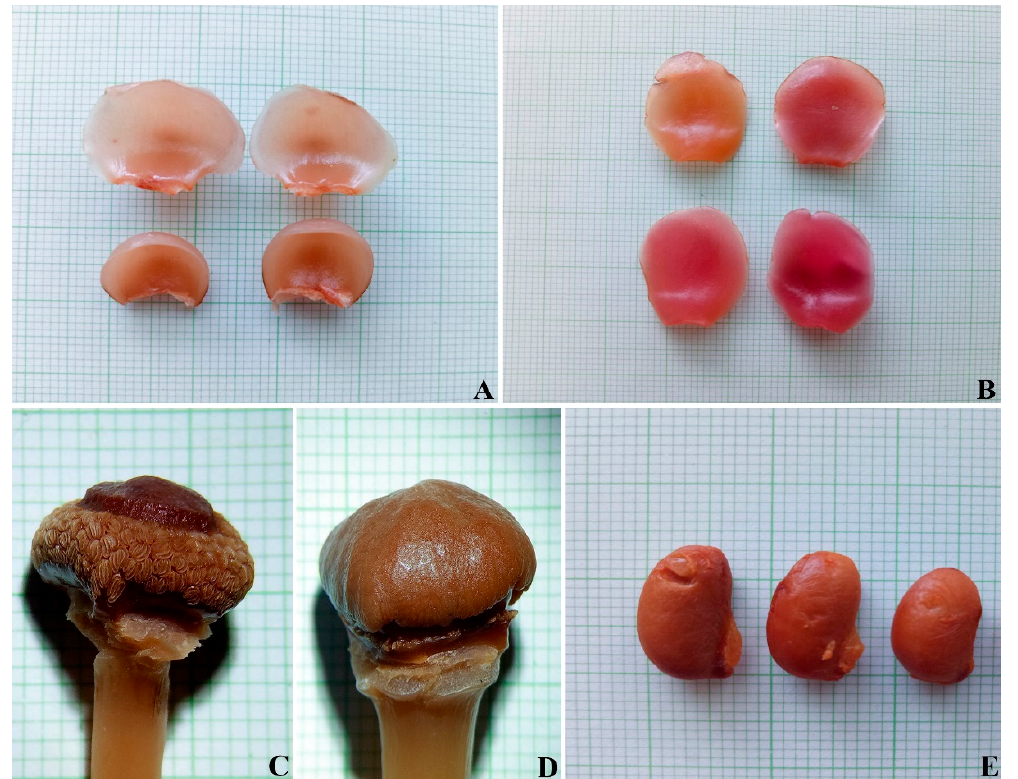
Figure 3. Garcinia atroviridis : ( A ) outer pair of sepals (lower) and inner pair of sepals (upper); ( B ) outer pair of petals (lower) and inner pair of petals (upper); ( C ) male flower showing stamens numerous, united in a ring central mass surrounding a pistillode (sepals and petals removed); ( D ) female flower showing pistil and staminodes (sepals and petals removed); ( E ) seeds. Photos: Weereesa Boonthasak.